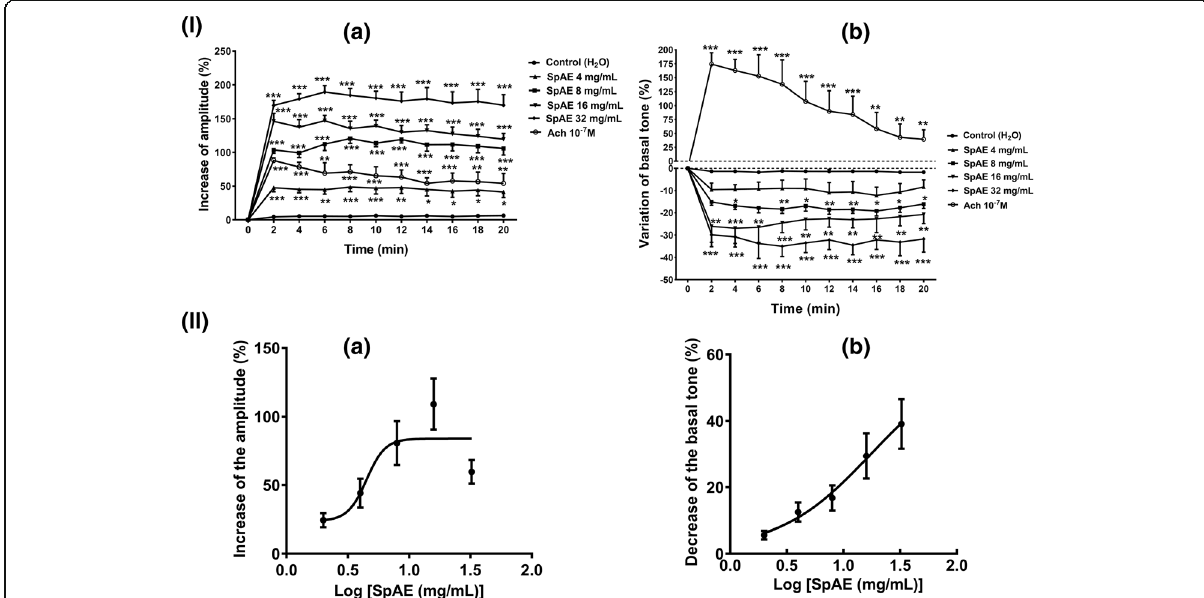
Fig. 5 Time-response curves ( I ) and concentration-response curves ( II ) of the effect of Sida pilosa aqueous extract alone or in the presence of pharmacological blockers on the amplitude ( a ) and the basal tone ( b ) of spontaneous contractions of isolated rat ileum. To evaluate the time- response effect of SpAE, it was separately administered (4, 8, 16 and 32 mg/mL) to the bath solution and the effect observed on spontaneous contractions for 20 min. The vehicle was administered at equivalent volume to that of the maximal concentration of extract. The percentages of variation of the tonus and the amplitude of spontaneous contractions were calculated considering the baseline values (before drug administration) as not changes (0%). To evaluate the concentration-response effect of SpAE, it was cumulatively administered (2, 4, 8, 16 and 32 mg/mL) to the bath solution at 10 min intervals. Each point represents the mean±SEM ( n =5). ANOVA followed by Newman-Keuls multiple comparison test was used for